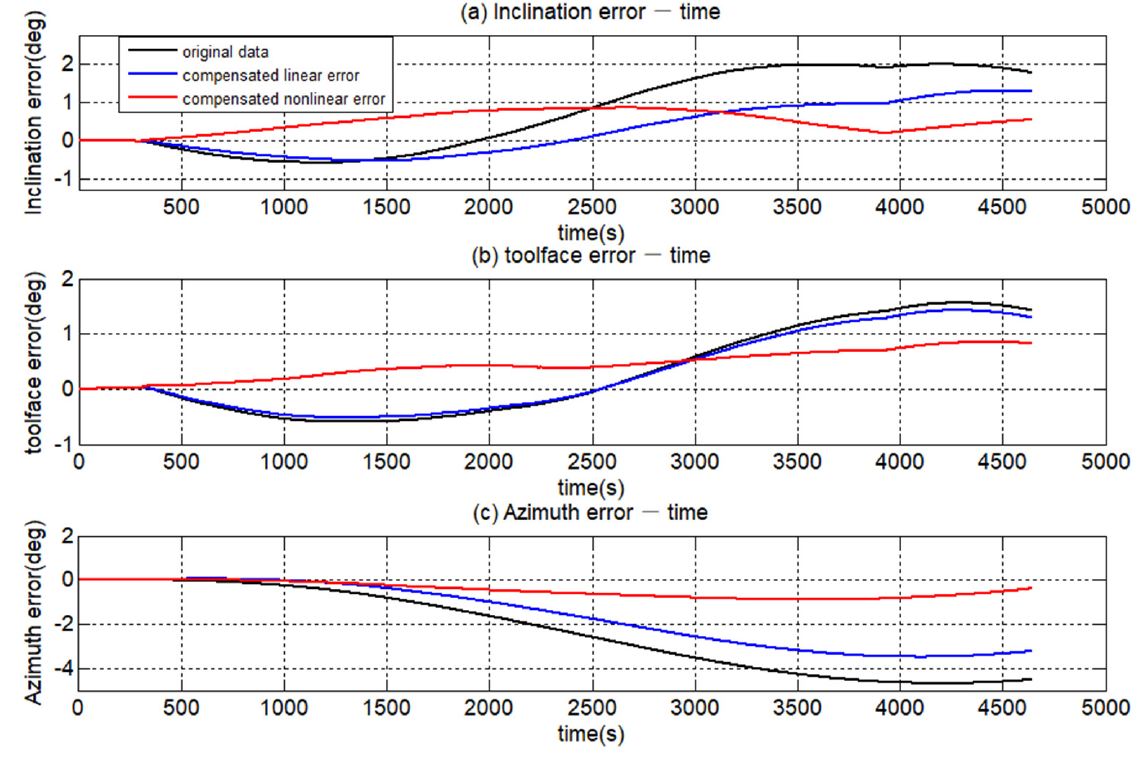
Figure 16. The attitude error. Table 5. The measurement error of the borehole